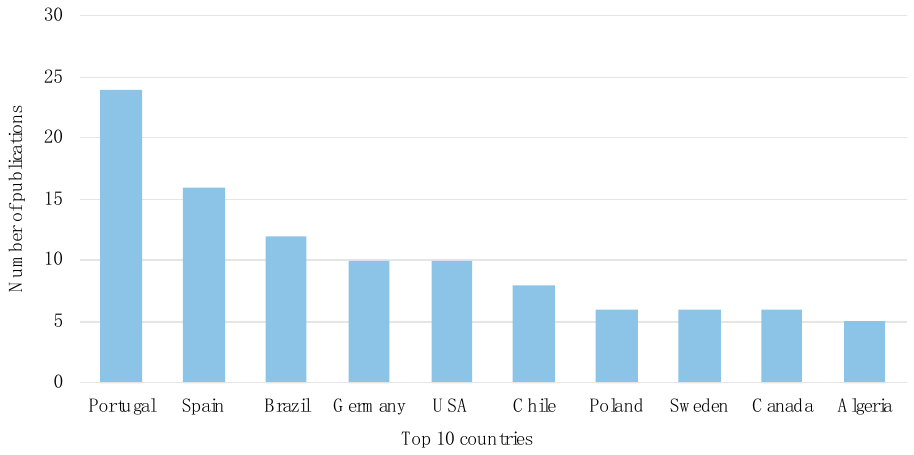
Figure 2. Distribution of publications among the top 10 publishing countries on cephalosporinases occurrence in wildlife.